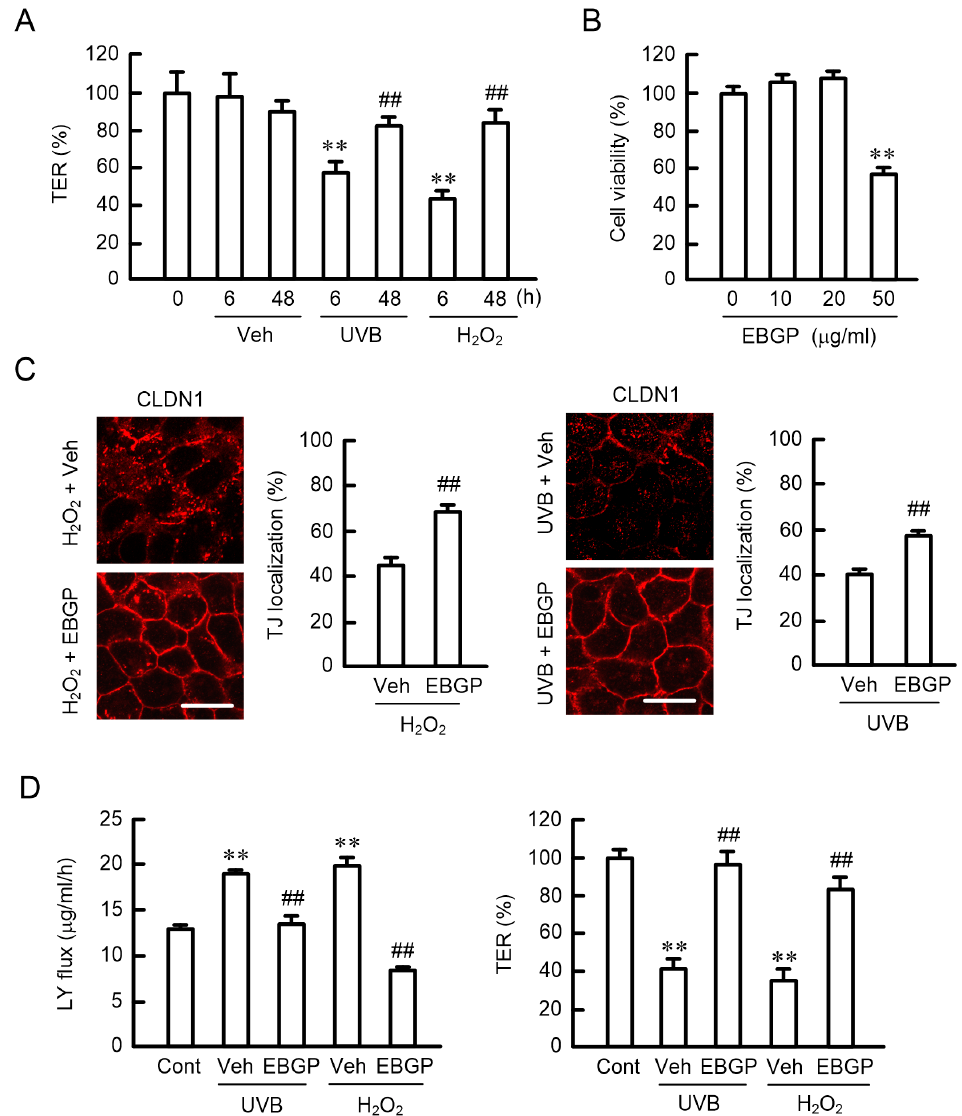
Figure 3. Effects of UVB, H 2 O 2 , and Brazilian green propolis (EBGP) on TJ permeability. ( A ) Cells plated on Transwell inserts were incubated with 50 mJ / cm 2 UVB or 200 µ M H 2 O 2 for the periods indicated. Transepithelial electrical resistance (TER) was measured using a volt-ohmmeter and is represented as